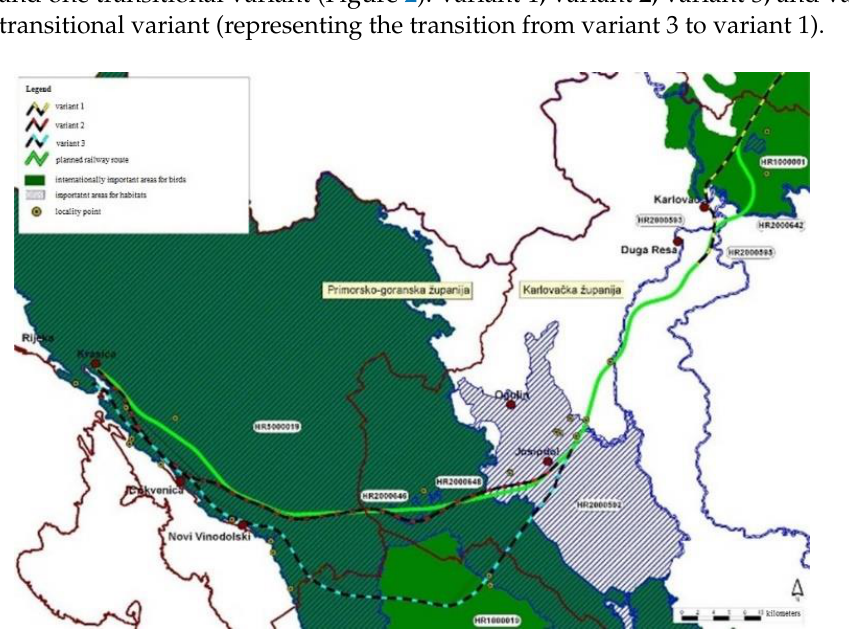
Figure 2. A clear overview of the analyzed railroad route variants [49].